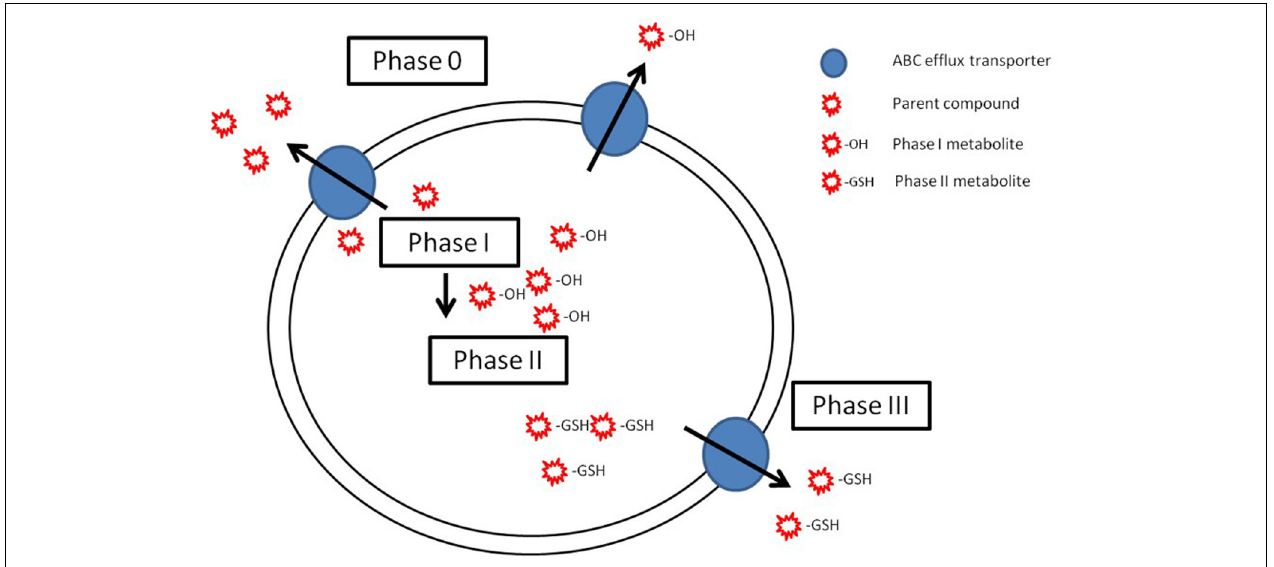
FIGURE 3 | Schematic representation of the possible cooperation of ABC efflux transporters (phase 0 and phase III) and biotransformation enzymes (phase I and phase II) in cellular detoxification. In phase 0, ABC transporters (blue circles) efflux the